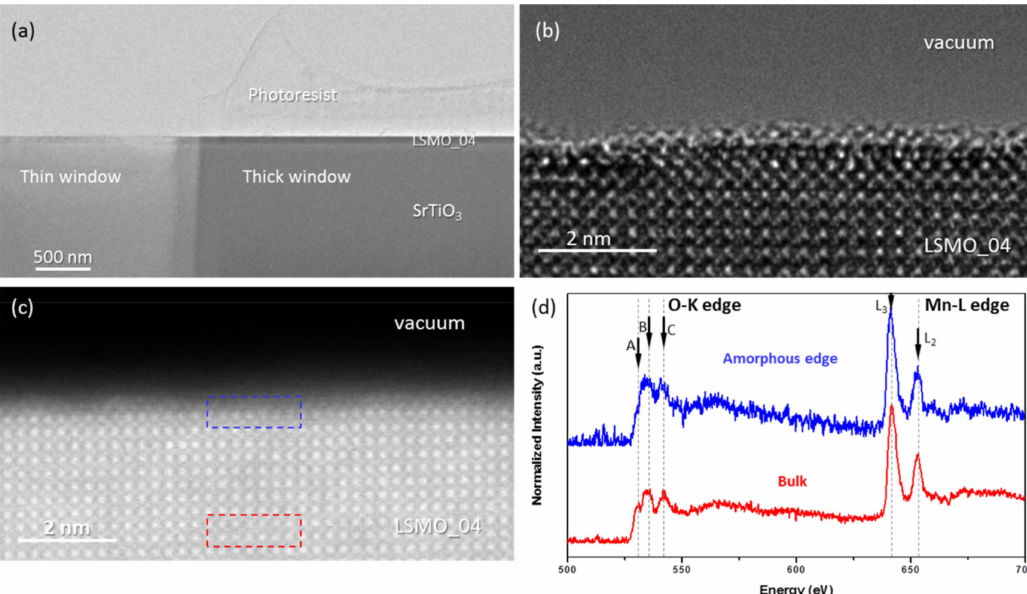
Figure 1. ( a ) Low magnification image of La 0.6 Sr 0.4 MnO 3 (LSMO) (x = 0.4) lamella prepared with the use of photoresist protection layer; ( b ) High-resolution transmission electron microscope (HRTEM) image of an edge collected from the thin window area; ( c ) high-resolution scanning TEM (HRSTEM) image, the areas marked with red and blue are used to collect electron energy loss spectroscopy (EELS) data (0.1 eV / channel) presented in ( d ). Spectral features marked with A, B, C, L 2 and L 3 are discussed in